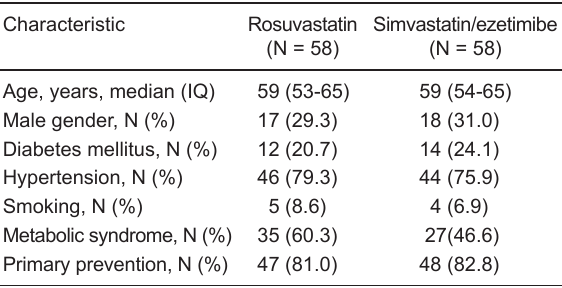
Table 1. Baseline characteristics of the study population accord- ing to treatment assignment. Characteristic